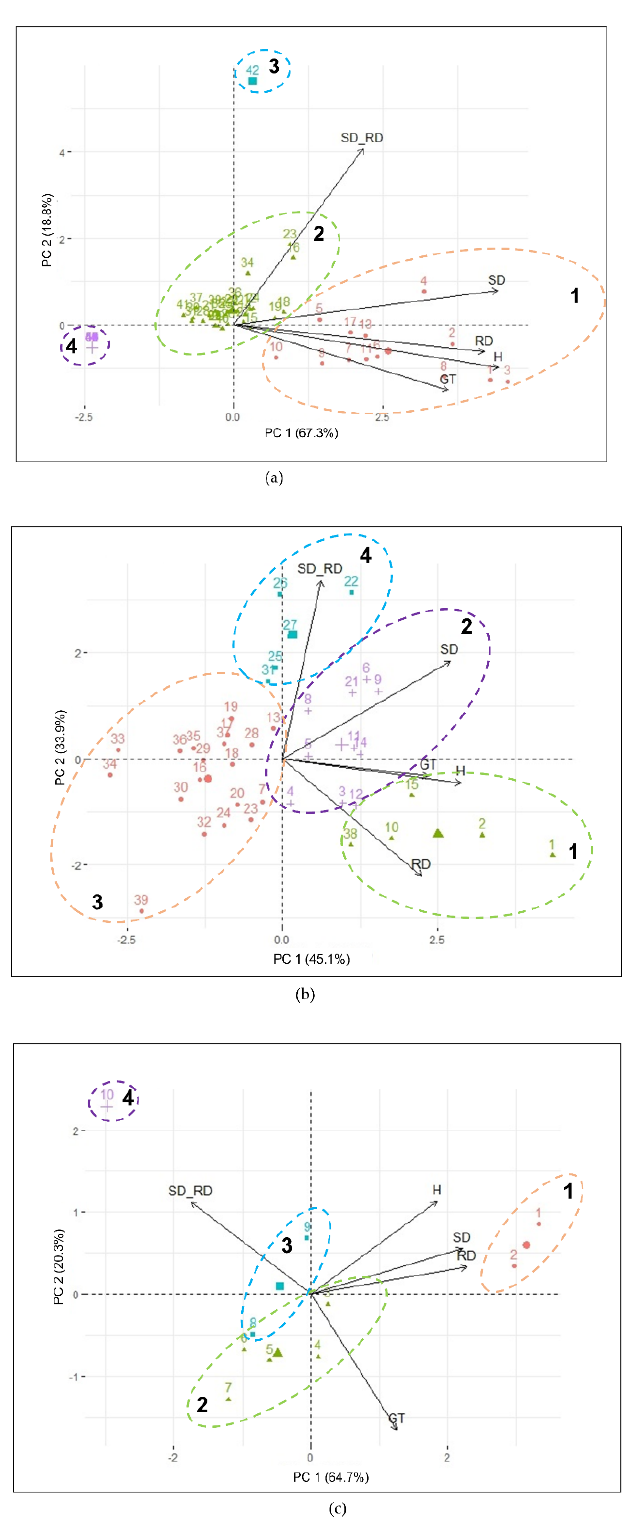
Figure 5. Principal component analysis (PCA) with principal component 1 and 2 (PC 1 and PC2). ( a ) PCA indicating the four clusters of the first scion/rootstock combination group. ( b ) PCA indicating the four clusters of the second scion/rootstock combination group. ( c ) PCA indicating the four clusters of the field scion/rootstock combination group. The variables used in the analysis were mean values of plant height (H), scion stem diameter (SD), rootstock stem diameter (RD), scion and rootstock stem diameter relation (SD_RD), and graft-take